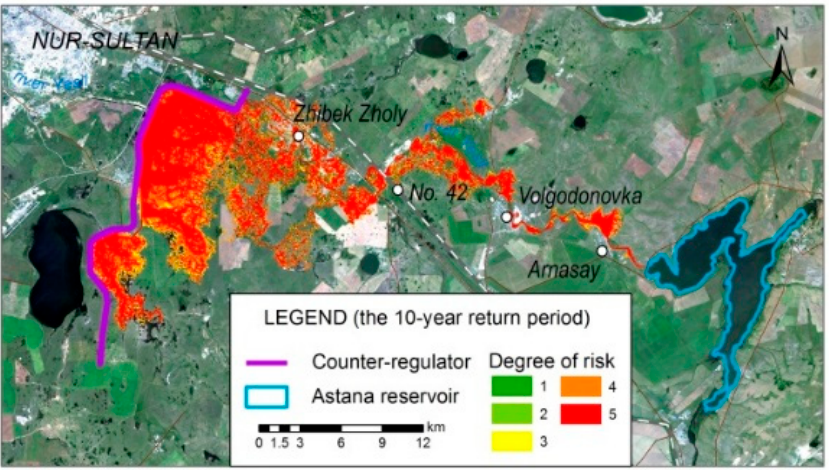
Water 2020 , 12 , x FOR PEER REVIEW Figure 11. Hazard map (Classification 2) produced from the 20-year return period flow hydrograph.